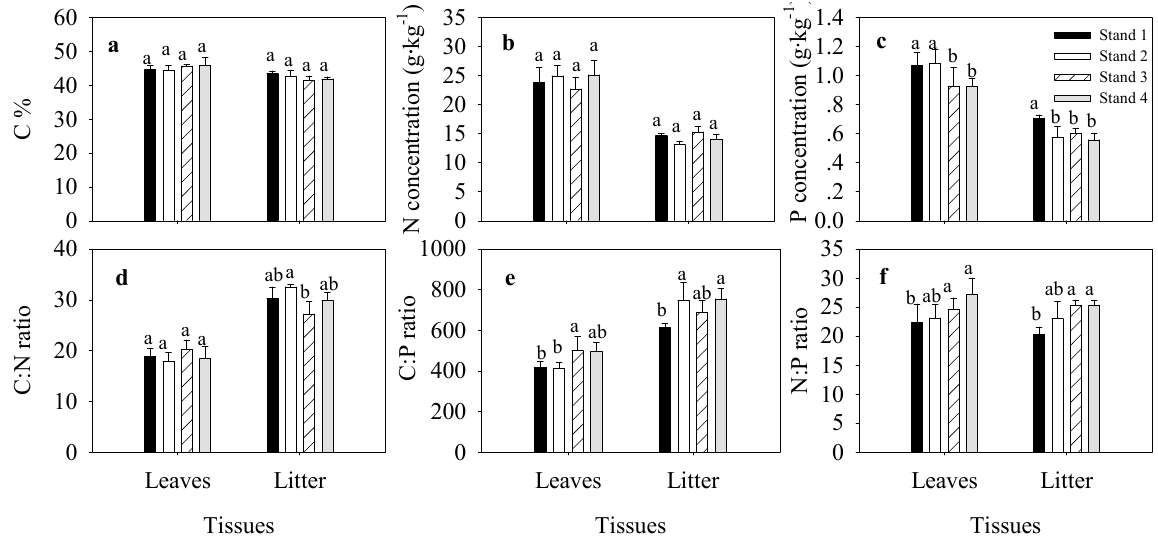
Figure 1. Carbon (C), nitrogen (N), and phosphorous (P) concentrations, and stoichiometry, in litter and leaves of moso bamboo ( Phyllostachysedulis ). The error bar was the mean value of four samplings (mean±SD, n =4), and different lowercase letters indicate significant differences between groups ( p ≤ 0.05). a–c, is the concentration of C, N, P of leaves and litter; d–f, is the stoichiometry of C:N ratio, C:P ratio and N:P ratio in leaves and litter.